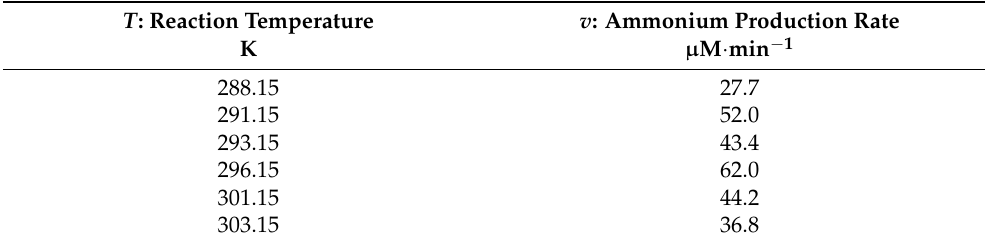
Table A1. Values obtained from the activity tests with nitrite reductase derived from spinach and one-electron reduced riboflavin.